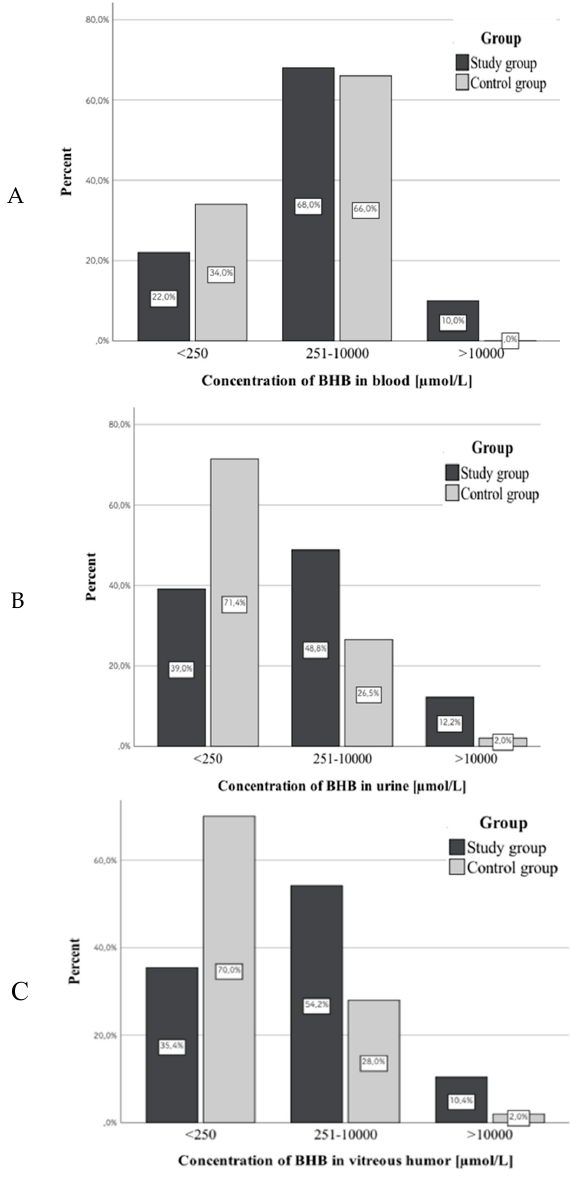
Figure 2. Correlations between the compared groups of subjects and β -hydroxybutyric acid (BHB) concentration in blood ( A ), urine ( B ), and vitreous humor ( C ). Table 7. Descriptive statistics for BHB determinations in the study and control groups for results in the range from 251 to 10,000 µmol/L.